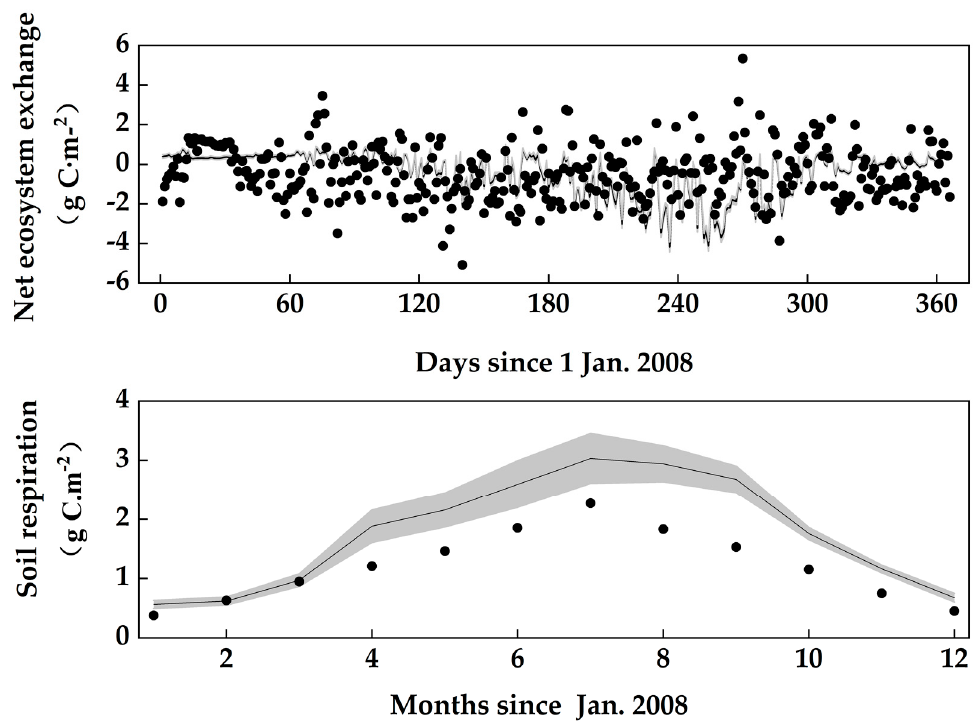
Figure 4. Comparison between modeled and observed values of net ecosystem carbon flux (NEE) and soil respiration (Rs) in 2008, constrained with a variety of different data (Run 5 in Table 1) (the solid line in the figure represents the average value of modeled results, the gray area represents the 95% confidence interval, and the blank circle represents the observed value). Table 4. Statistics of C flux simulation results for the Huitong subtropical Chinese fir plantation.